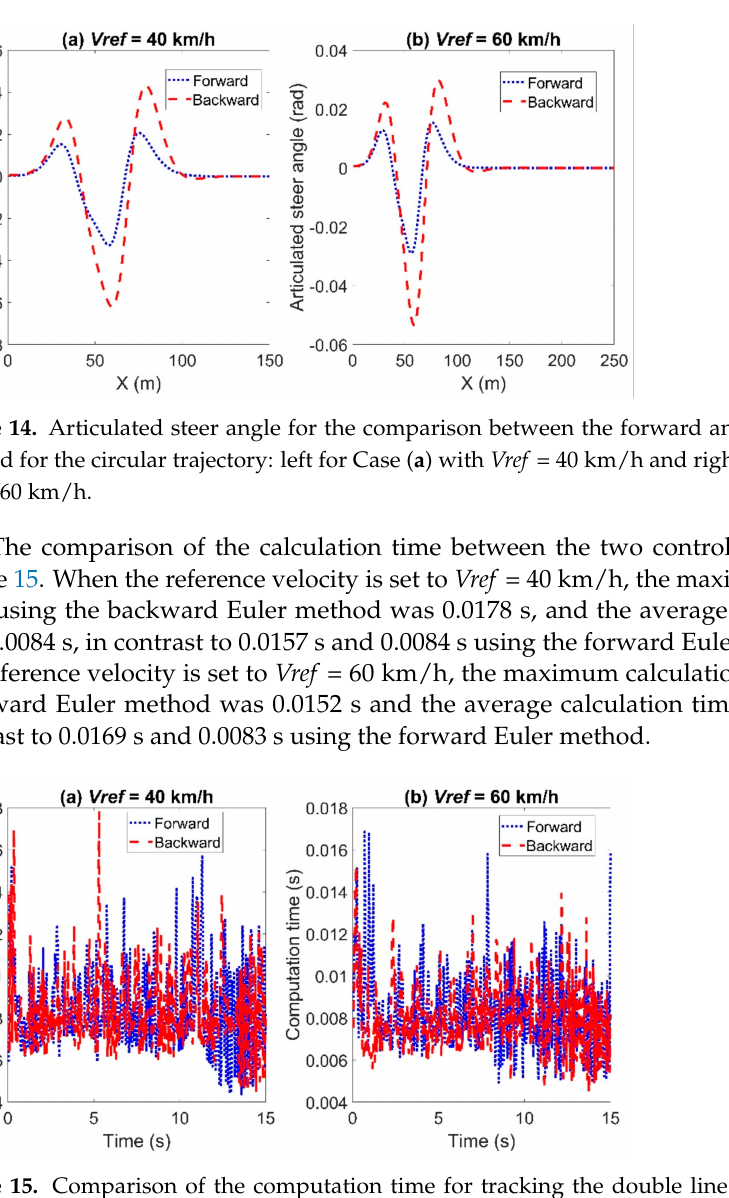
Figure 13. Articulated acceleration for the comparison between the forward and backward Euler method for the circular trajectory: left for Case ( a ) with Vref = 40 km/h and right for Case ( b ) with Vref = 60 km/h.